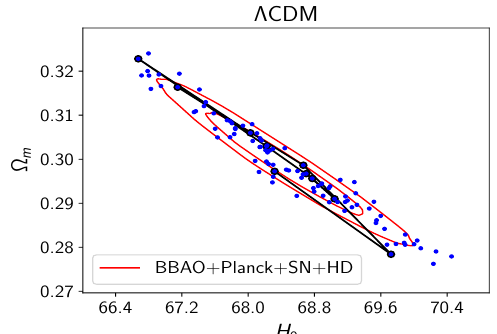
Figure 17. Top panel: Markov chain for the parameter H 0 , with 9000 steps. Bottom panel: Two- dimensional posterior distribution with confidence regions 1 and 2 σ for the joint parameters H 0 and Ω m .